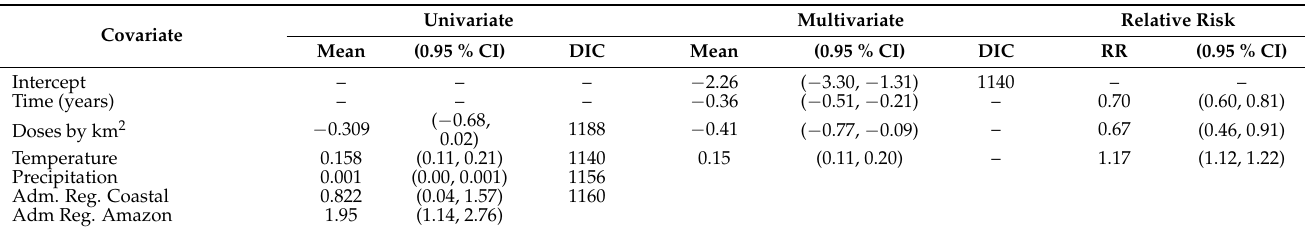
Table 7. Summary fixed effects of covariates on the estimated risk (RR) of CSF in a spatiotemporal Bayesian model in Ecuador 2017–2020.